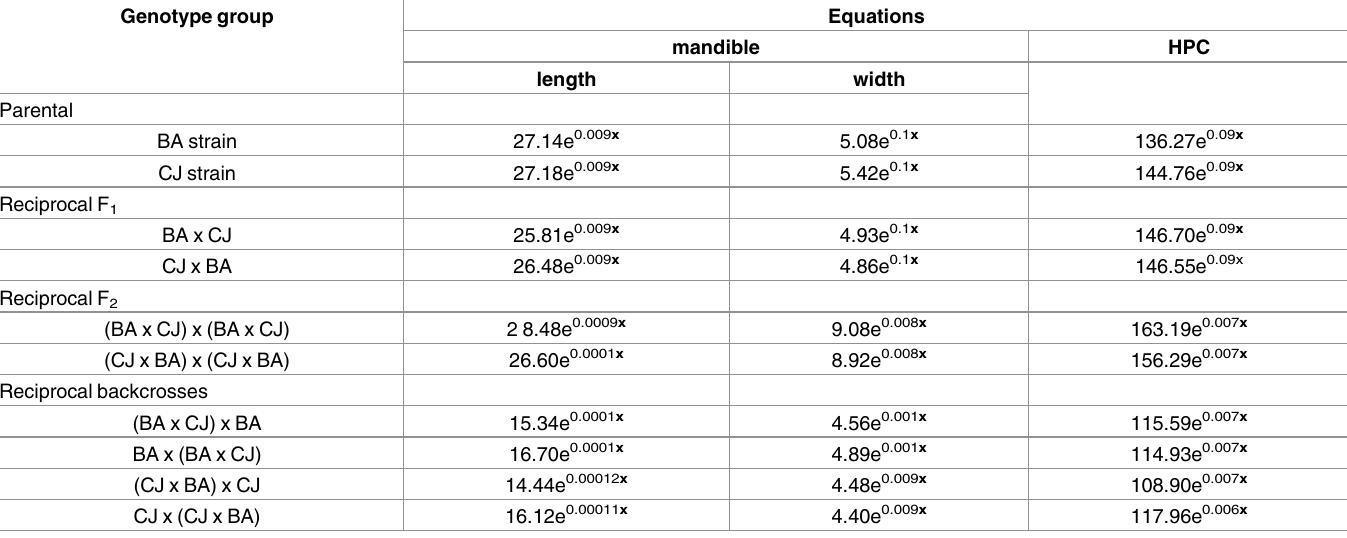
Table 1. Exponential equations computed to the growth in length and width of mandibles and HPC in larvae of the BA and CJ parental strains, reciprocal F 1 , reciprocal F 2 and backcrosses, D . gaucha . The larvae were 24, 48, 72, 96, 120, 144, 168, and 192 h of age (N = 50 individualsper group of genotypes and larval age; see Materialsand methods). For all crosses, the first parent shown is the